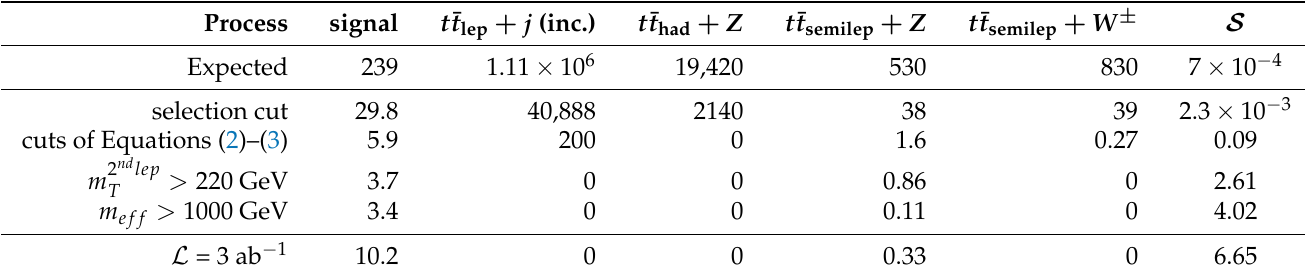
Table 1. Cut flow with L = 1 ab − 1 corresponding to the Left case signal production. The last column is the significance with a systematic uncertainty in the background of 30%. The last row is the projection to L = 3 ab − 1 .